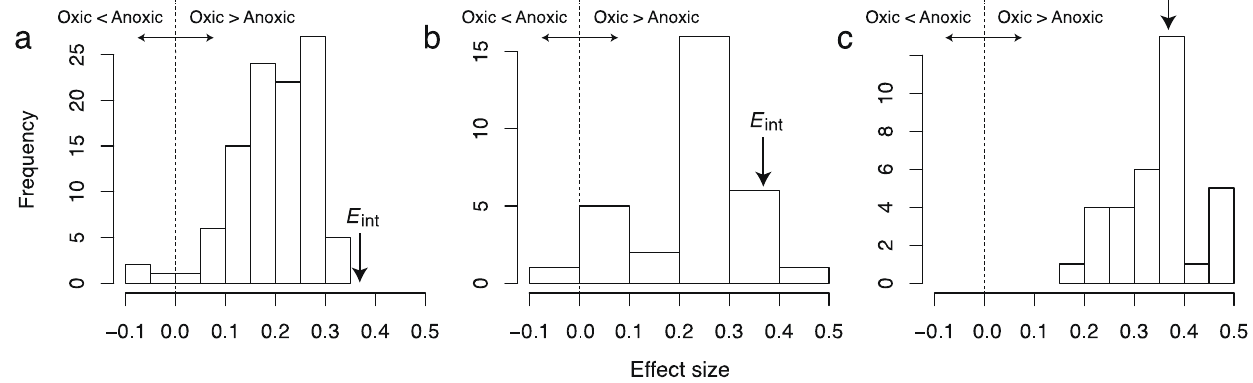
Figure 2. Distributions of effect sizes of the difference in AlogP98 between oxic and anoxic metabolites in individual metabolic networks of (a) aerobic bacteria, (b) unicellular eukaryotes, and (c) multicellular eukaryotes. E integral